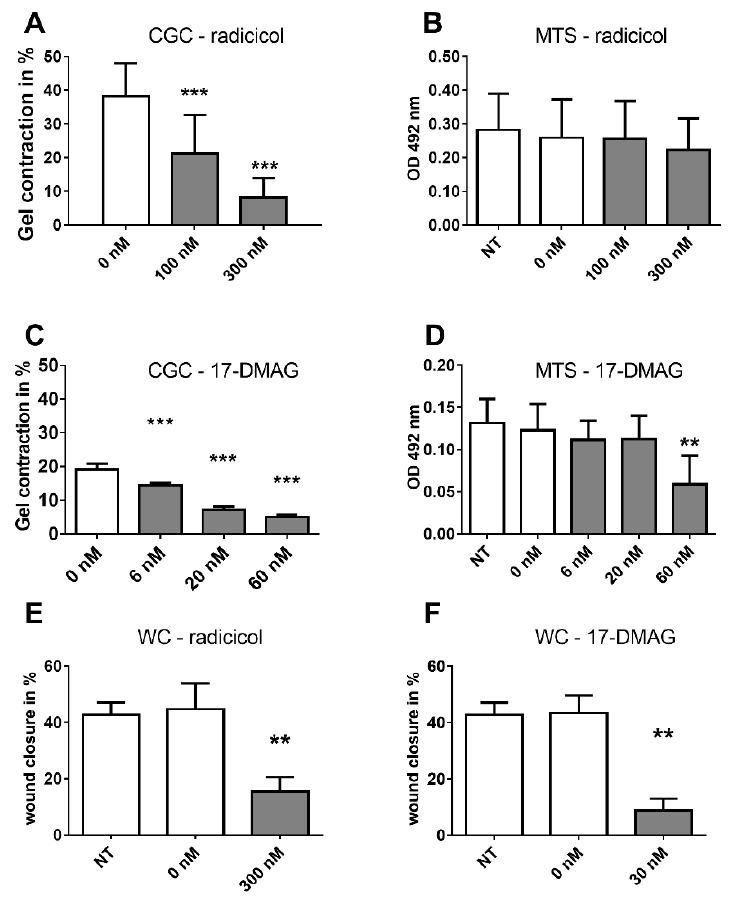
Figure 3. Effects of HSP90 inhibitors upon CAF contractility and mobility. ( A ) Radicicol inhibited collagen gel contraction (CGC) by CAF in a dose-dependent manner ( p < 0.001 for all doses and time points vs. vehicle control; n = 21 experiments in triplicates for 0 nM, n = 18 for 100 nM and n = 16 for 300 nM with a total of 11 different CAF lines; unpaired two-sided t -test); ( B ) Treatment with radicicol did not reduce cell viability, as measured with an MTS assay after the CGC ( n = 10 independent experiments and CAF lines; repeated measures ANOVA, p > 0.05; not significant). NT = no treatment; 0 nM received the dose of vehicle comparable to the highest treatment dose; ( C ) 17-DMAG significantly inhibited collagen gel contraction in a dose-dependent manner ( n = 3 CAF lines and independent experiments in triplicates; repeated measures ANOVA, p < 0.001 for all doses); ( D ) 17-DMAG showed little effect upon cell viability in an MTS assay of CAF after the CGC except for the highest dose of 60 nM ( n = 3 independent experiments and CAF lines; repeated measures ANOVA, p < 0.01); ( E ) Radicicol treatment (300 nM) reduced CAF migration in wound closure (WC) in the scratch assay after 24 h. n = 5 CAF populations, paired, two-sided t -test. NT = no treatment; ( F ) 30 nM 17-DMAG reduced migration in the scratch assay in CAF after 24 h. n = 5 CAF populations, p < 0.01 paired, two-sided t -test. All panels: mean + S.E.M. and asterisks denote the level of significance: * for p < 0.05, ** for p < 0.01 and *** for p < 0.001. Incubation times: CGC 48 h, MTS 3 h, WC 24